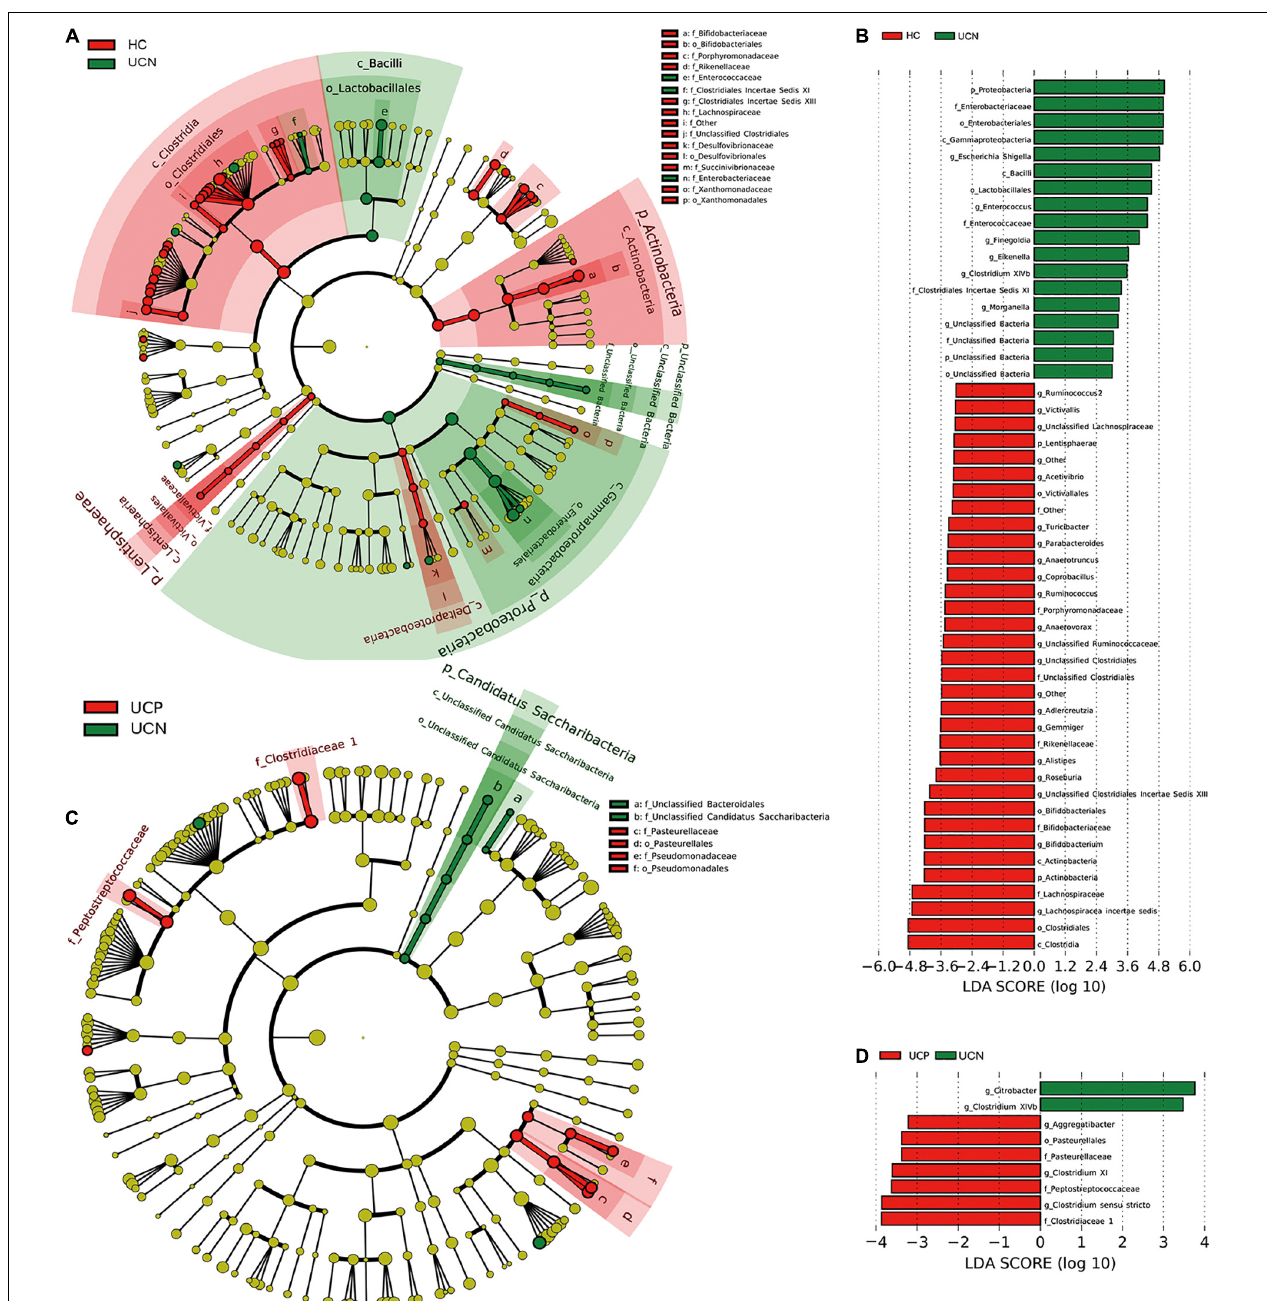
FIGURE 3 | Differential relative abundance of bacterial taxa among the three groups. (A) A cladogram made by LEfSe demonstrates different bacterial taxa between the HC and UCN groups. (B) LDA score of enriched bacterial taxa between the HC and UCN groups. Only taxa meeting an LDA > 3 are shown. (C) A cladogram made by LEfSe demonstrates different bacterial taxa between the UCN and UCP groups. (D) LDA score of enriched bacterial taxa between the UCN and UCP groups. Only taxa meeting an LDA > 3 are shown. HC, healthy control group; UCN, ulcerative colitis with negative Clostridioides difficile test results; UCP, ulcerative colitis with positive Clostridioides difficile